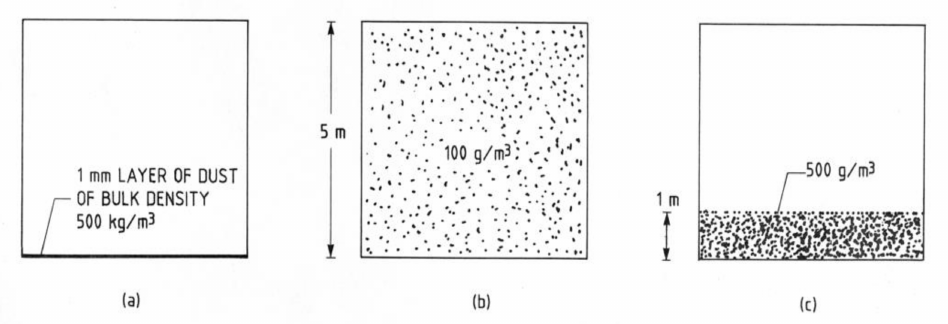
Figure 3. Illustration of the potential secondary-dust-explosion hazard of even thin dust layers. ( a ) Illustrates that a 1 mm thick dust layer of a dust of bulk density 500 kg/m 3 will, as ( b ) illustrates, generate a cloud of average concentration 100 g/m 3 , if dispersed in a room of 5 m height. As illustrated in ( c ), dispersion to only 1 m cloud height will give 500 g/m 3 , i.e. in the middle of the explosible range. From Eckhoff [1–3]. Copyright (2019), with permission from